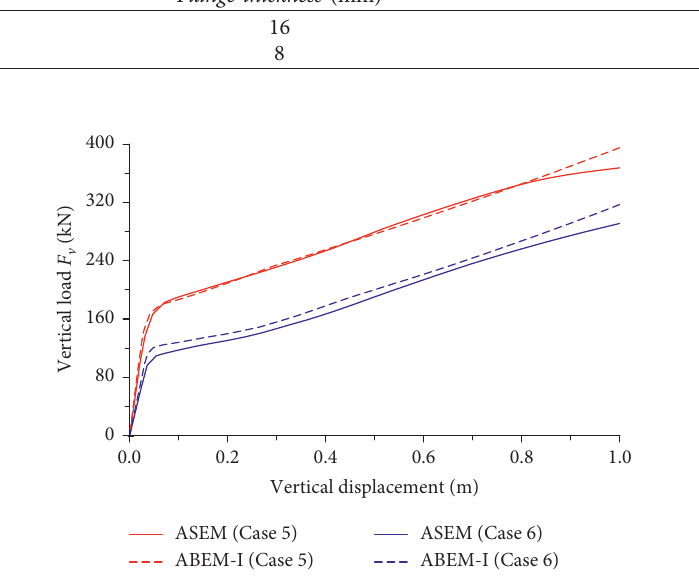
Figure 15: Load to vertical displacement curves of Cases 5 and 6.